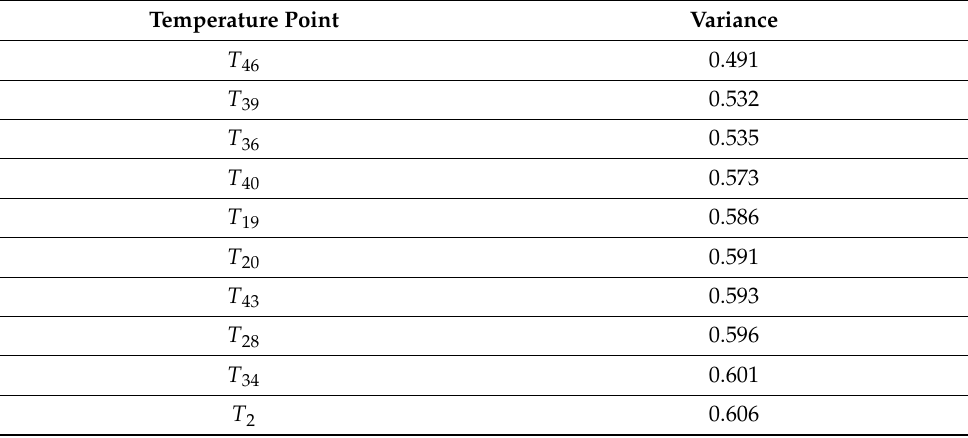
Table 2. The variance of the first ten ITPs.